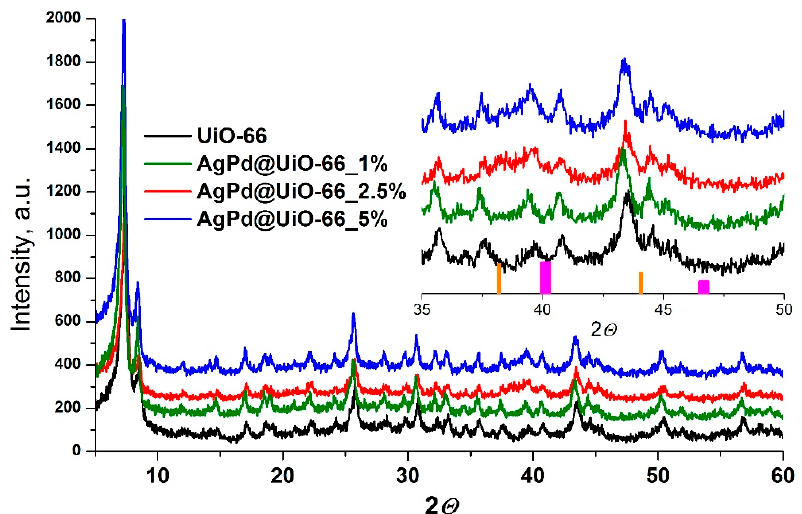
Figure 7. XRD pattern of UiO-66 (black) and AgPd@UiO-66 samples with 1% (green), 2.5% (red), and 5% (blue) metal loading.